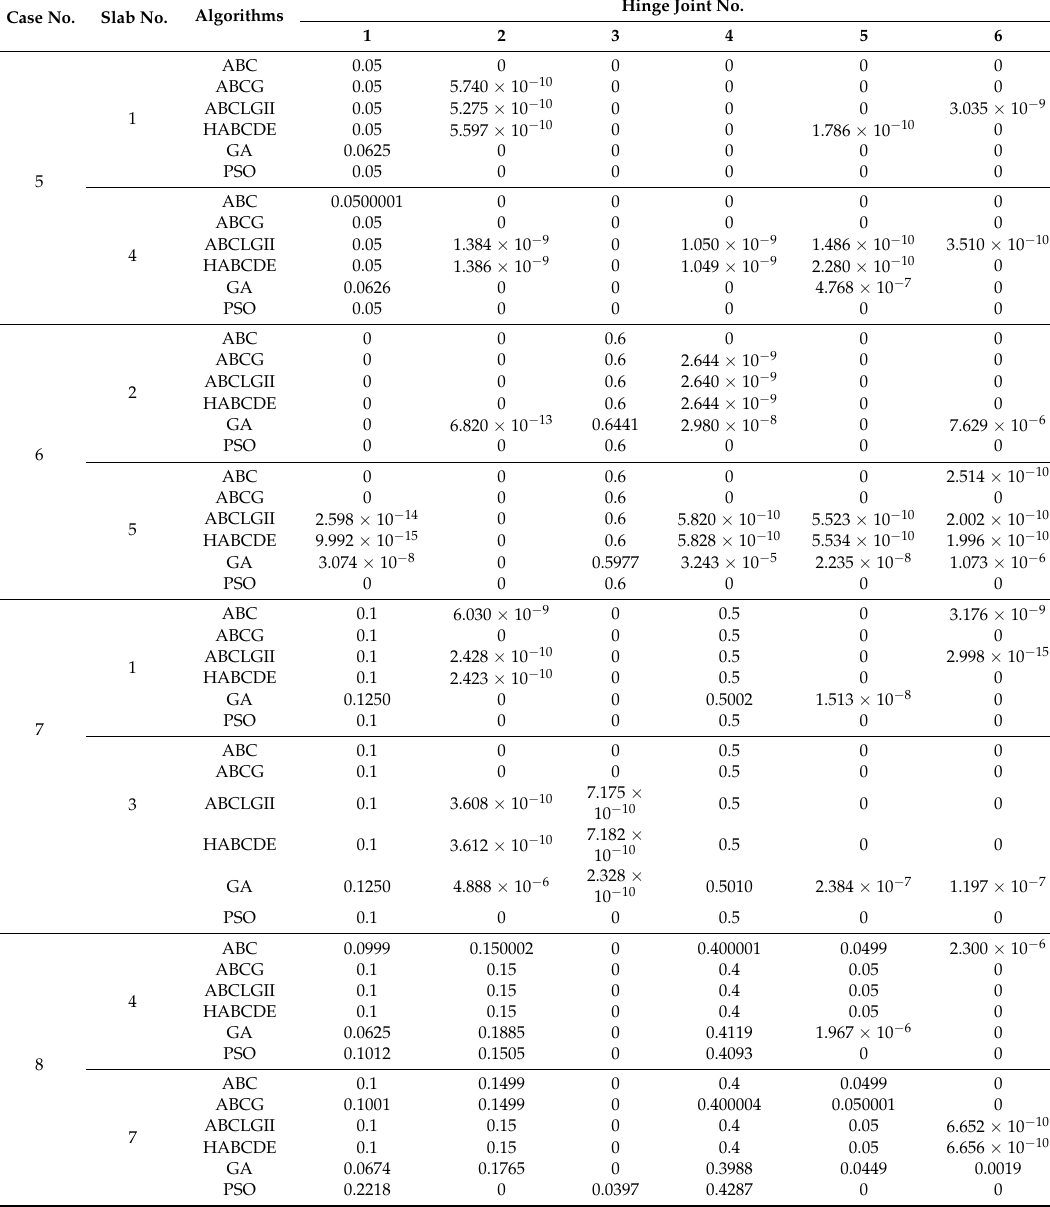
Table 9. Damage identification results for case 5 to case 8.